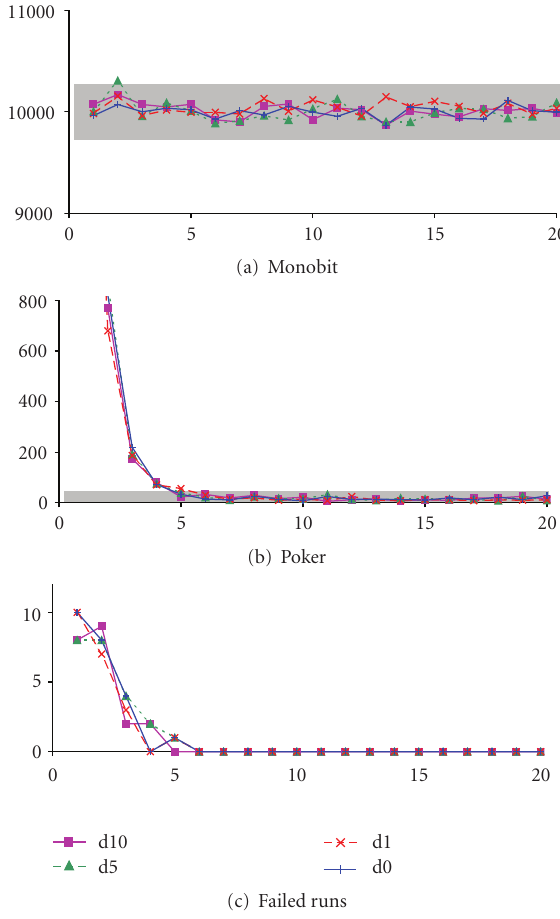
Figure 10: Results of the FIPS 140-2 test of the Wold’s TRNG architecture simulations while injecting a Gaussian jitter with σ = 30ps and a varying size of deterministic jitter, with internal reference